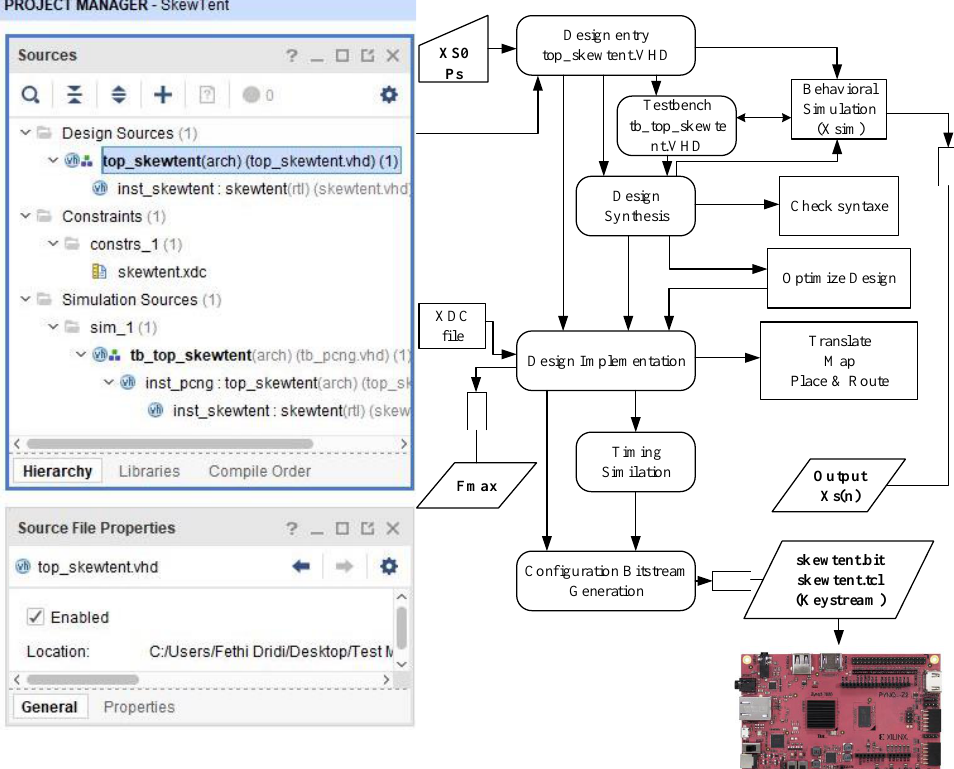
Figure 4. The design flow of the Skew-Tent map on FPGA using